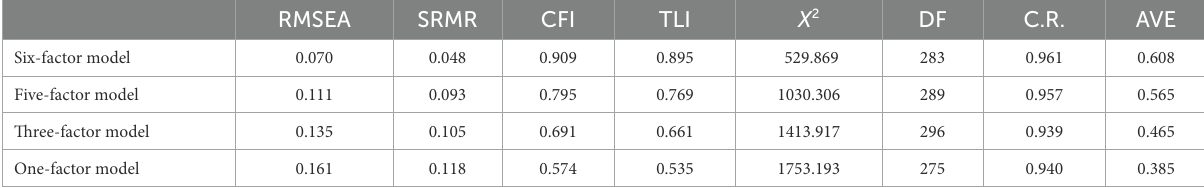
TABLE 2 The results of confirmatory factor